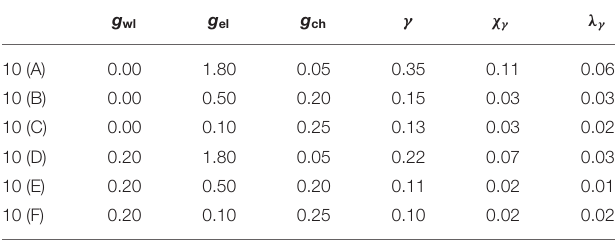
TABLE 2 | Parameter sets used in Figure 10 .